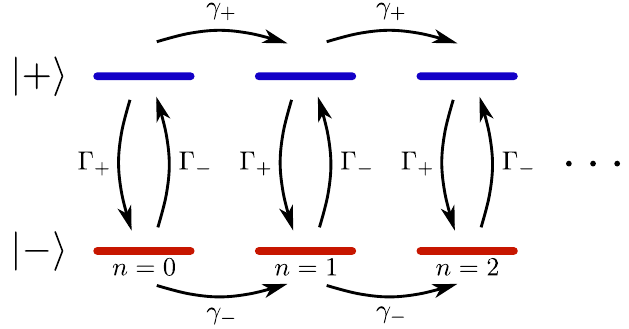
FIG. 8. Unraveling of the NV-center charge readout dynamics. The state jþi ( j − i ) represents NV − (NV 0 ). Photons are detected at state-dependent rates γ . Each detection increases the number (cid:3) of observed photons n . The rates Γ describe ionization or (cid:3) recombination processes that are not associated with the detection of a